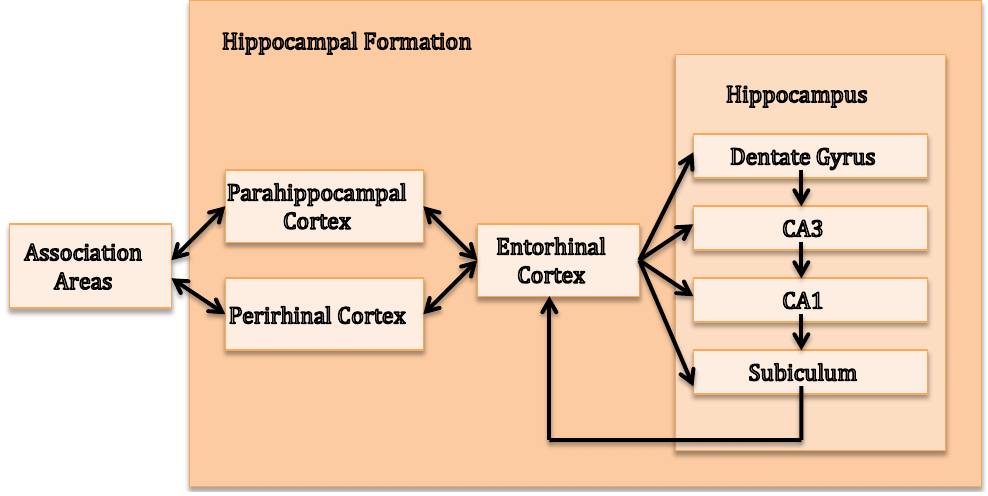
Figure 1. Input and output pathways of the hippocampal formation (adapted from